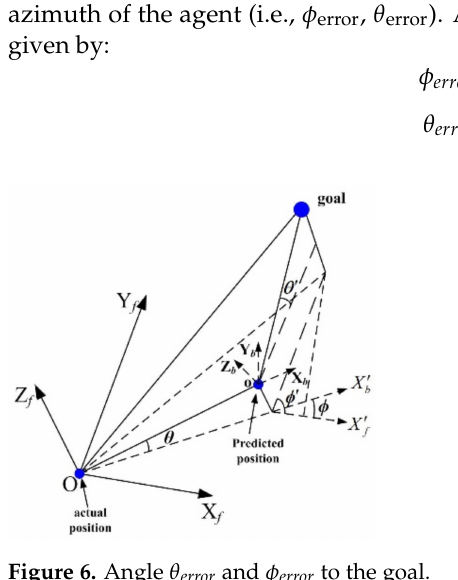
Figure 6. Angle θ error and φ error to the